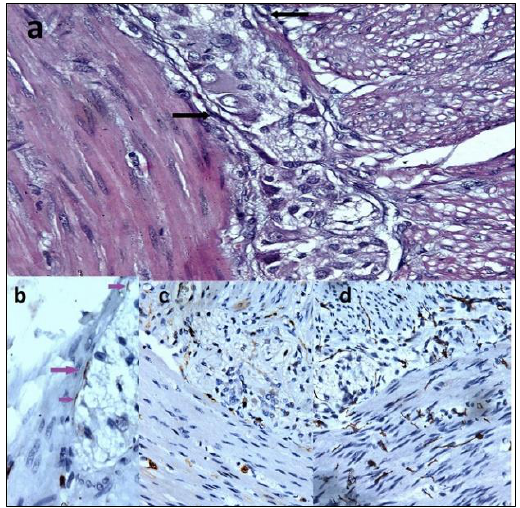
Figure 2- a) Interstitial cells of Cajal (ICCs) (arrow) around the myentric plexus (H&E, X400), b) Grade 1 immunostained intersti-